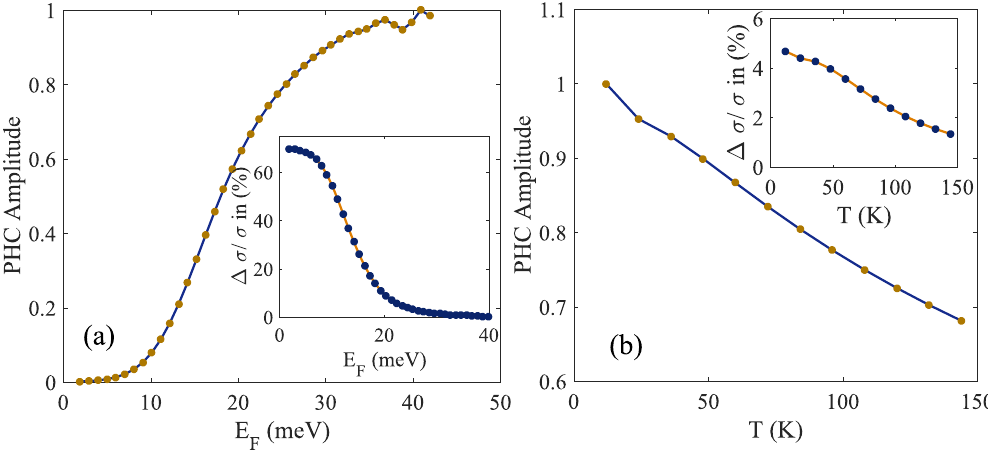
Figure 4. ( a ) Shows the amplitude of planar Hall conductivity ( θ = π ) in the presence of orbital magnetic 4 moment as a function of Fermi energy for B = 5 T and T = 24 K for the bulk states of Bi 2 Se 3 (Inset Shows the behavior of LMC ( θ = 0) as a function of Fermi energy). It is important to note that the magnitudes of LMC and PHC behave very differently as the band filling approaches the bottom of the conduction bands. The Fermi energy is measured from the bottom of the lowest conduction band. ( b ) Shows the temperature dependence of the amplitude of planar Hall conductivity ( θ = π ) in the presence of m for B = 5 T for the bulk states of Bi 2 Se 3 4 (Inset shows the temperature dependence of LMC ( θ = 0)). The amplitude of PHC has been normalized by its maximum value in both